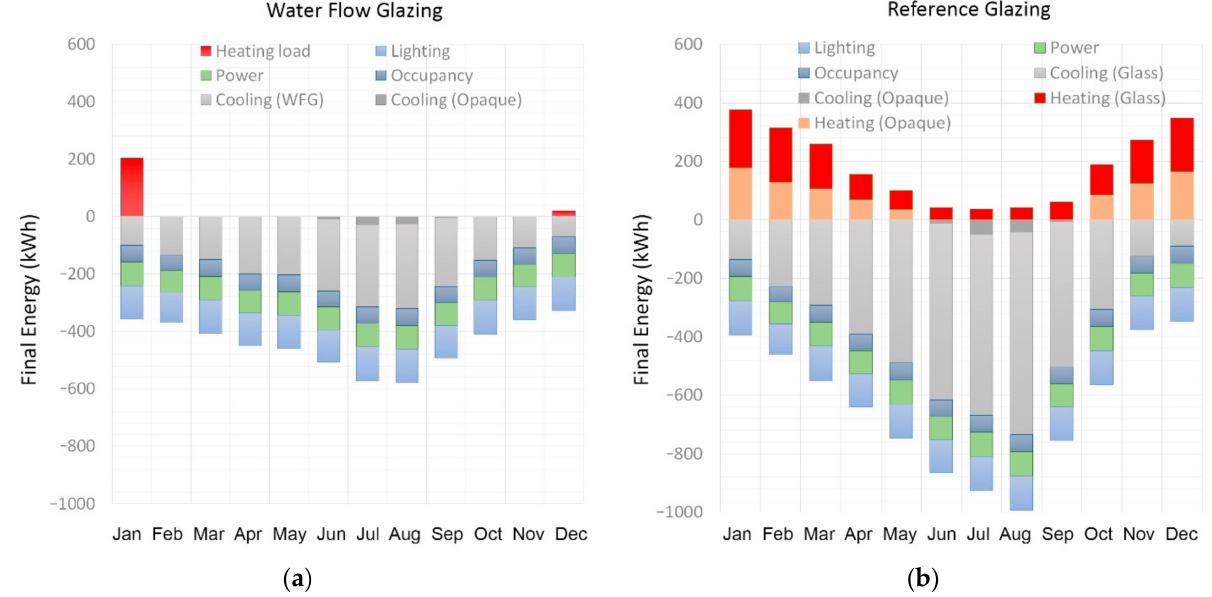
Figure 7. Estimation of final electric energy consumption of the prototypes: ( a ) Water Flow Glazing prototype with a water-to-water heat pump; ( b ) Reference glazing prototype with an air-to-air heat